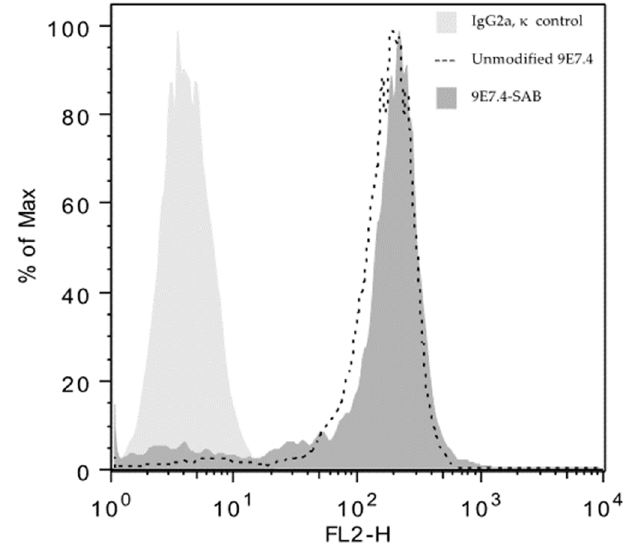
Figure 1. Flow cytometry data on 5T33 MM (multiple myeloma) cells showing the specific binding of unmodified 9E7.4 and modified 9E7.4 SAB (N-succinimidyl-3-[211At]astatobenzoate prosthetic group). Antibodies were incubated for 1 h and revealed with an anti-rat secondary antibody labeled with phycoerythrin.